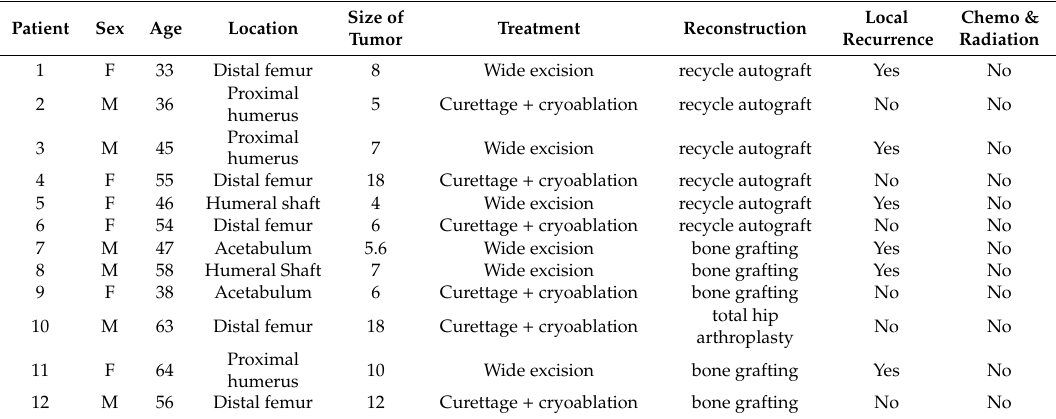
Table 3. Demographic data of giant cell tumor patients for comparative proteomic